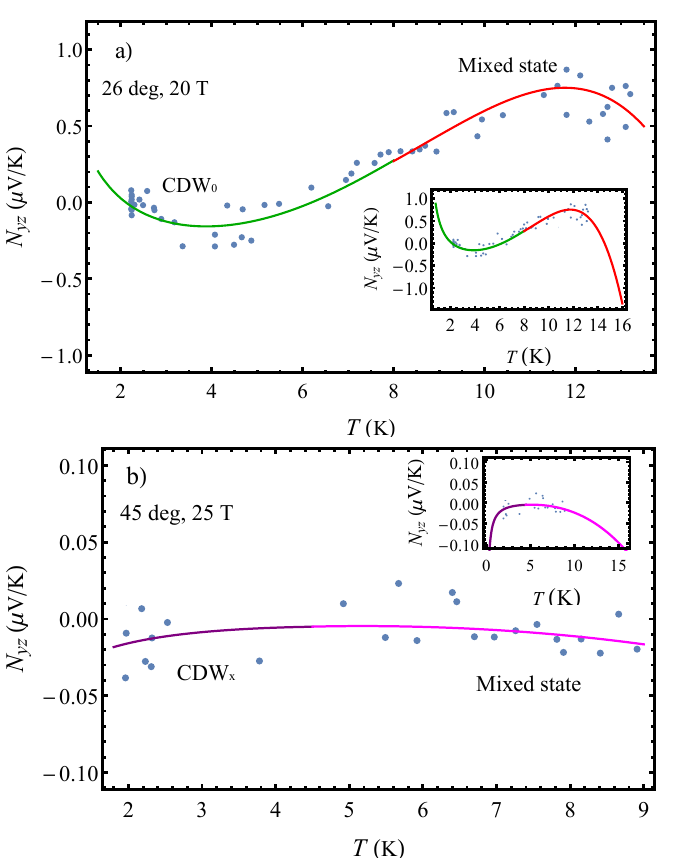
Figure 8. Temperature dependence of the Nernst effect, N yz ( T ) , in α - ( BEDT-TTF ) 2 KHg ( SCN ) 4 obtained at: ( a ) θ = 26 ◦ , B = 20 T and ( b ) θ = 45 ◦ , B = 25 T. The prominent change in the temperature profile of Nernst effect is evident with increasing tilt angle and magnetic field strength. The insets show the predicted temperature profile of the Nernst effect outside of the measured temperature